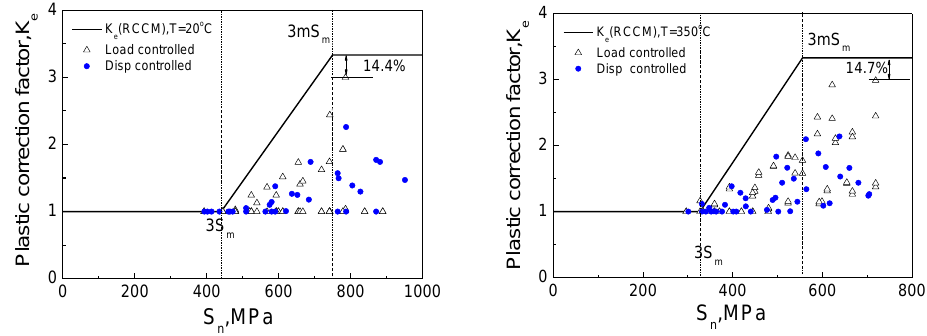
Figure 9. K e with S n under different temperatures with notched sheet model. Table 3. Results of K e under thermal load of Z2CND18.12 (nitrogen control) for nozzle model.